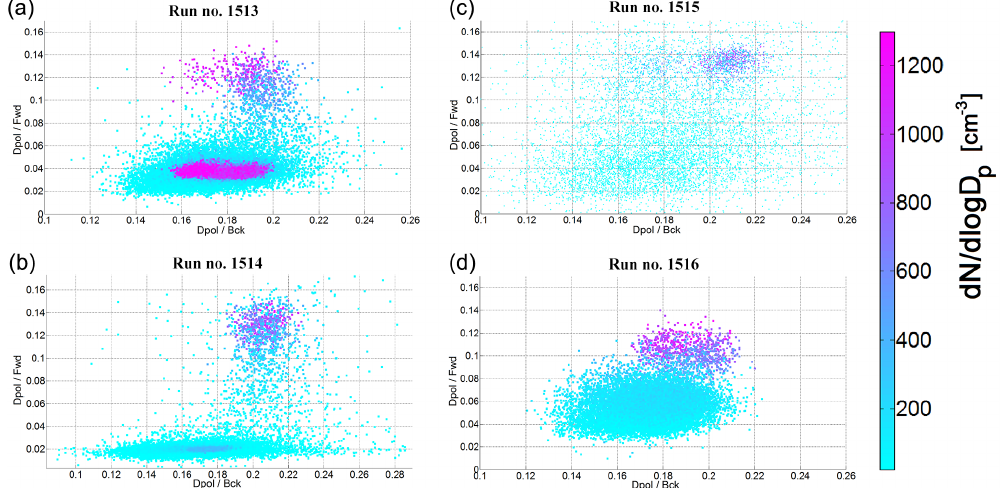
Figure 6. Polarization scatter plots of SOA growth and liquefaction measured by CASPOL in four experiments. Ratio of perpendicularly polarized backscatter to forward scatter intensity (Dpol/Fwd) vs. ratio of perpendicularly polarized backscatter intensity to total backscatter intensity (Dpol/Bck), 1s averaged run periods where the concentration was below 1300cm − 3 , colour is concentration d N /dlog D p [cm − 3 ], (a) run no. 1513, (b) run no. 1514, (c) run no. 1515, (d) run no. 1516.